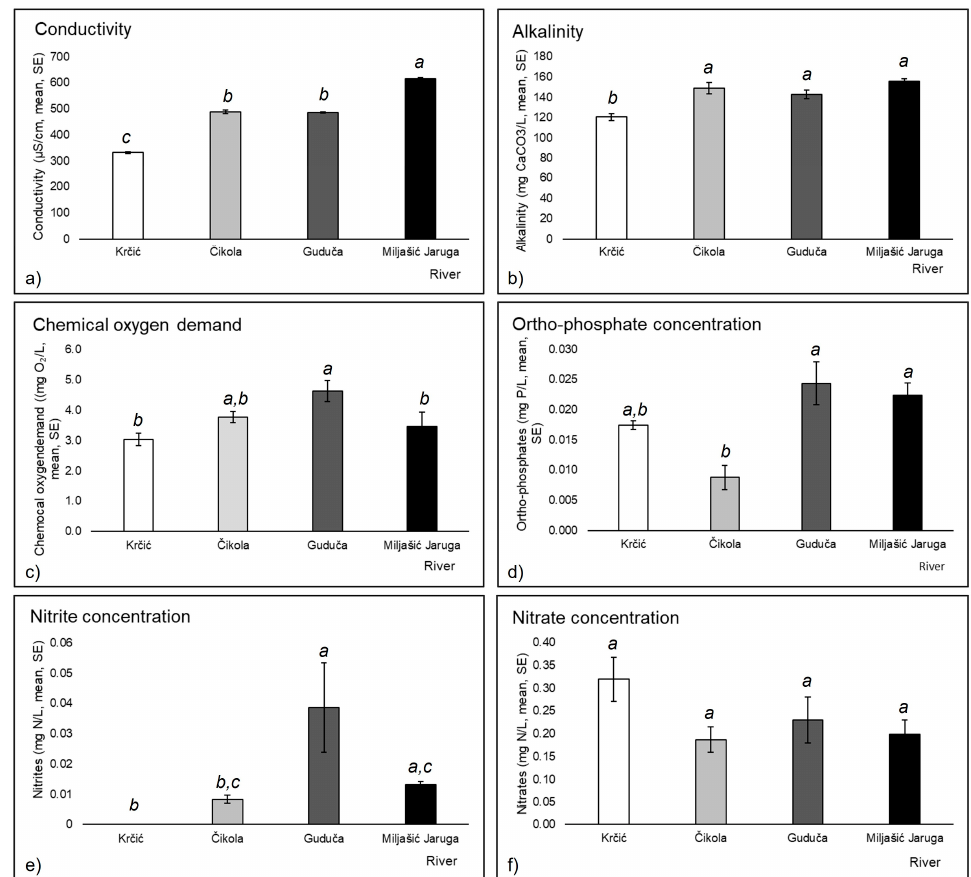
Figure 3. Physico-chemical parameters of the water measured at four intermittent rivers in the karst Mediterranean region of the Balkans shown as mean with standard error (SE): ( a ) conductivity, ( b ) alkalinity, ( c ) chemical oxygen demand, ( d ) orthophosphate concentration, ( e ) nitrite concentration, ( f ) nitrate concentration.